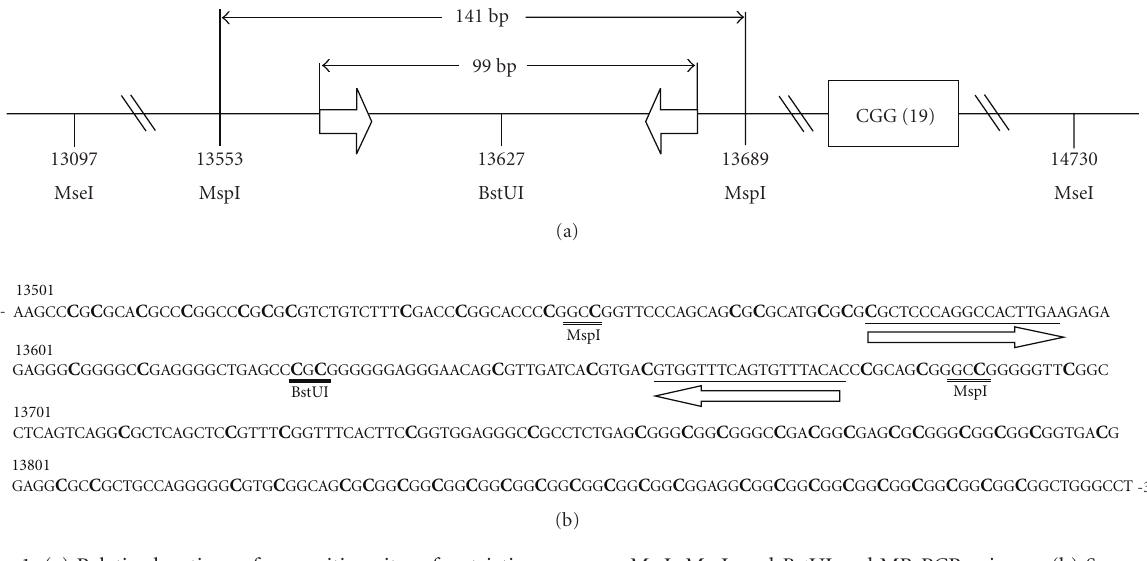
Figure 1: (a) Relative locations of recognition sites of restriction enzymes Mse I, Msp I, and Bst UI and MB-PCR primers. (b) Sequence of FMR1 promoter region. The methylated cytosine of CpG dinucleotides is indicated by an enlarged letter “C”; the recognition sites of Msp I and Bst UI are double underlined; the primers are indicated by arrows.